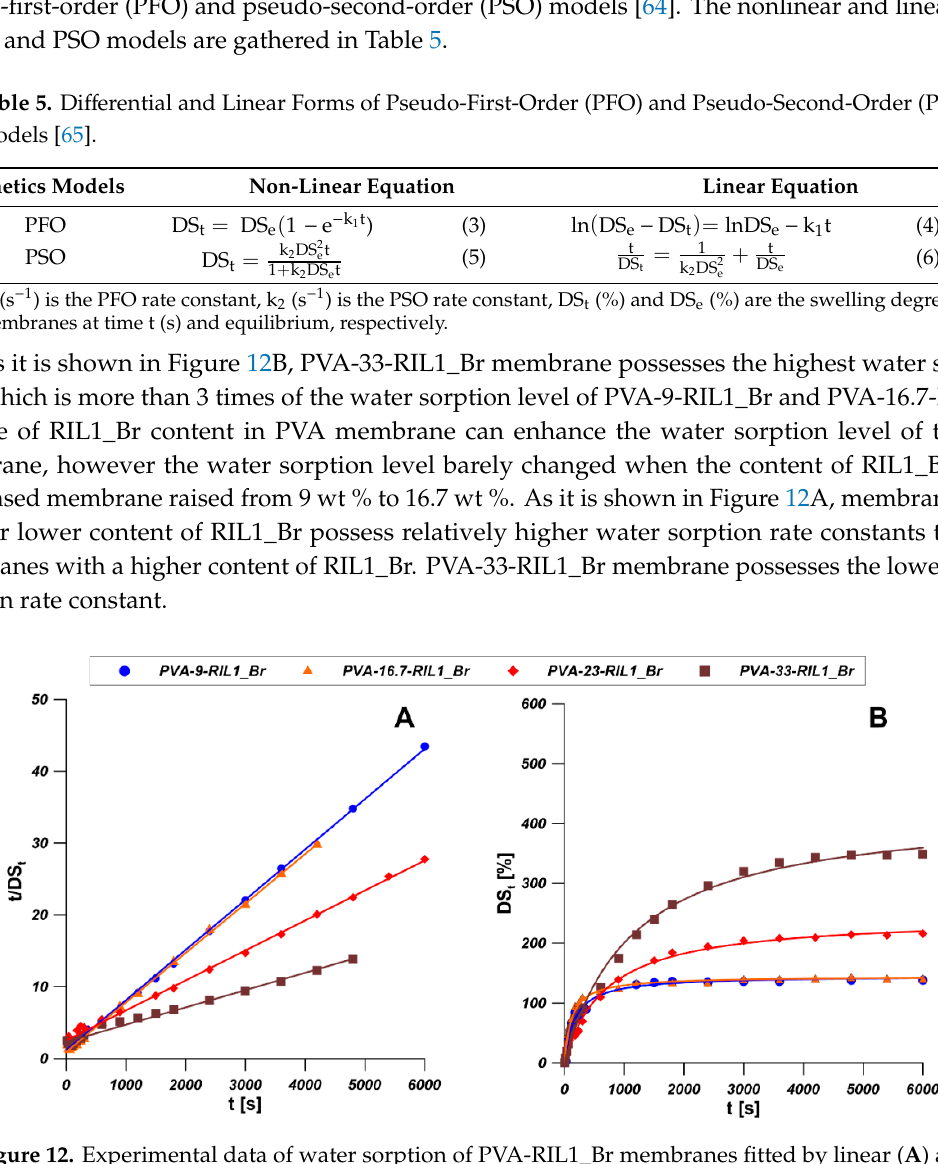
Figure 13. Experimental data of water sorption on PVA-RIL2_Br membranes fitted by linear ( A ) and non-linear ( B ) forms of PFO kinetic model. In comparison with these two types of PVA membranes, the increasing content of RIL1_Br and RIL2_Br shows a similar effect on the water sorption level of PVA membranes. However, the